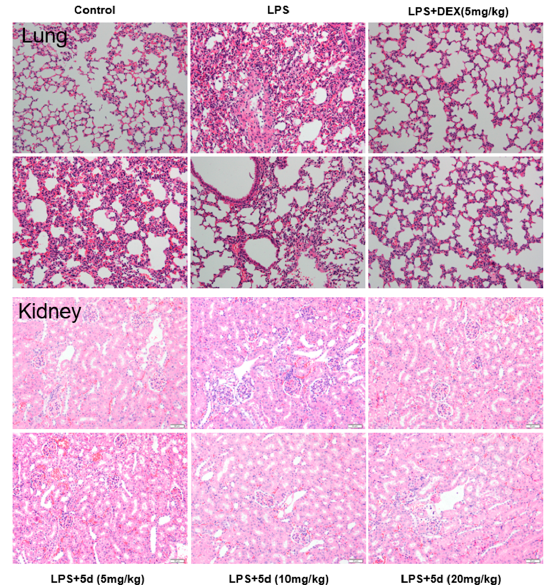
Figure 12. Effect of compound 5d on histopathological changes of lung and kidney tissues in the endotoxemia mice model ( n = 10). Mice were intraperitoneally injected with LPS (4 mg/kg), then intraperitoneally injected with compound 5d (5, 10, 20 mg/kg) at the 0th/5th/10th h, dissected at the 12th h. The fixed sections of the tissues and histopathological changes of the tissues were assessed by H and E staining (200×) .